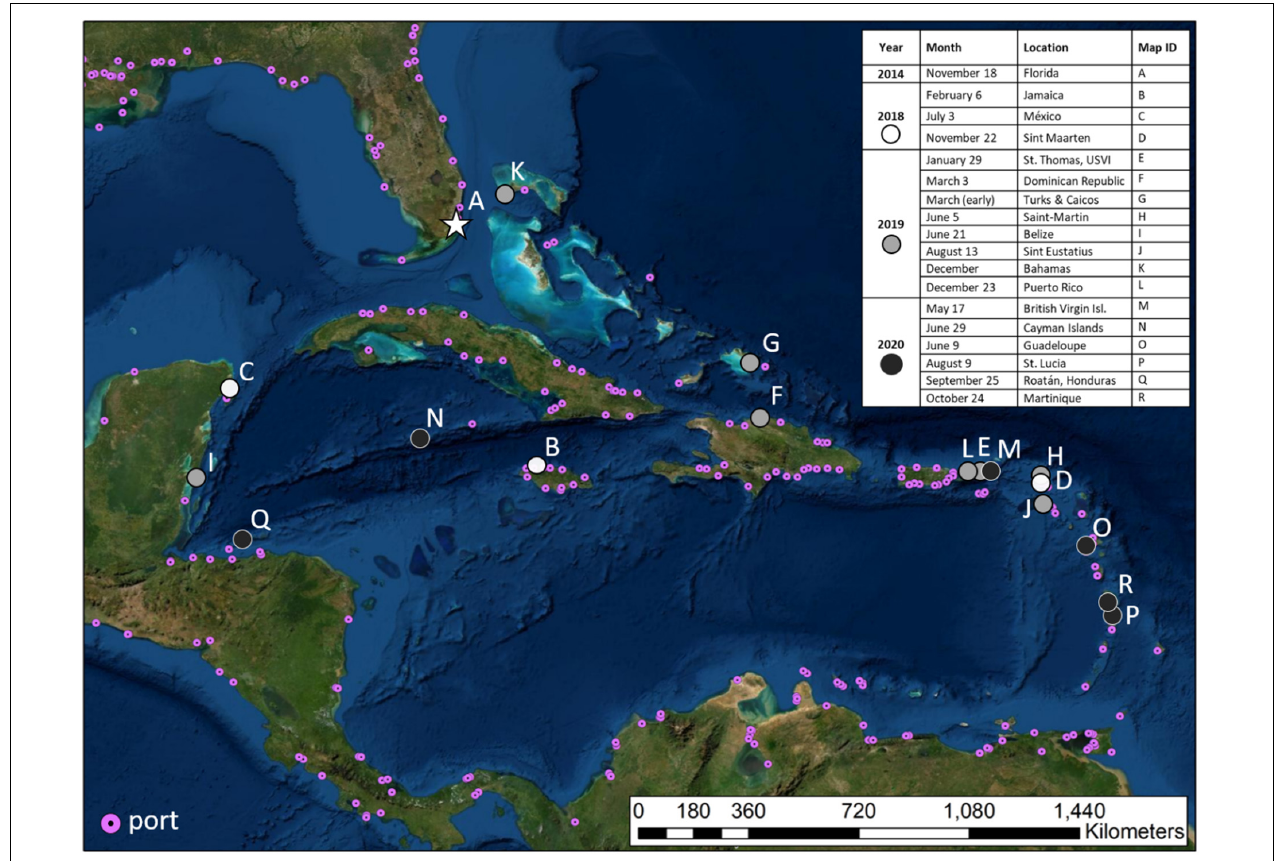
FIGURE 1 | Spatial distribution of stony coral tissue loss disease across the Caribbean through time. Map modified from Roth et al. (2020).